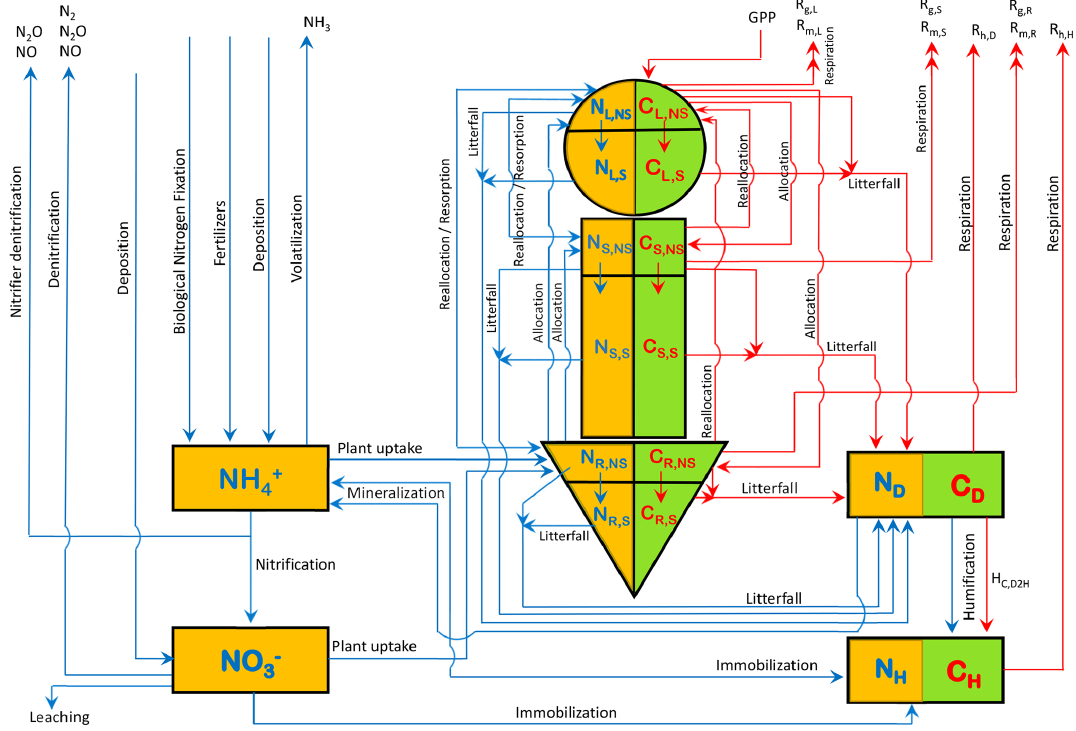
Figure 1. The structure of the CLASSIC model used in this study. The 8 prognostic carbon pools are shown in a green colour, and carbon fluxes in a red colour. The 10 prognostic nitrogen pools are shown in an orange colour, and nitrogen fluxes are shown in a blue